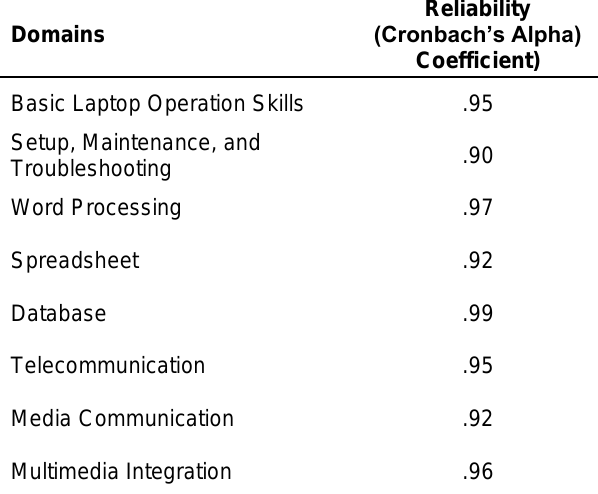
Table 1. Content Specification for Laptop